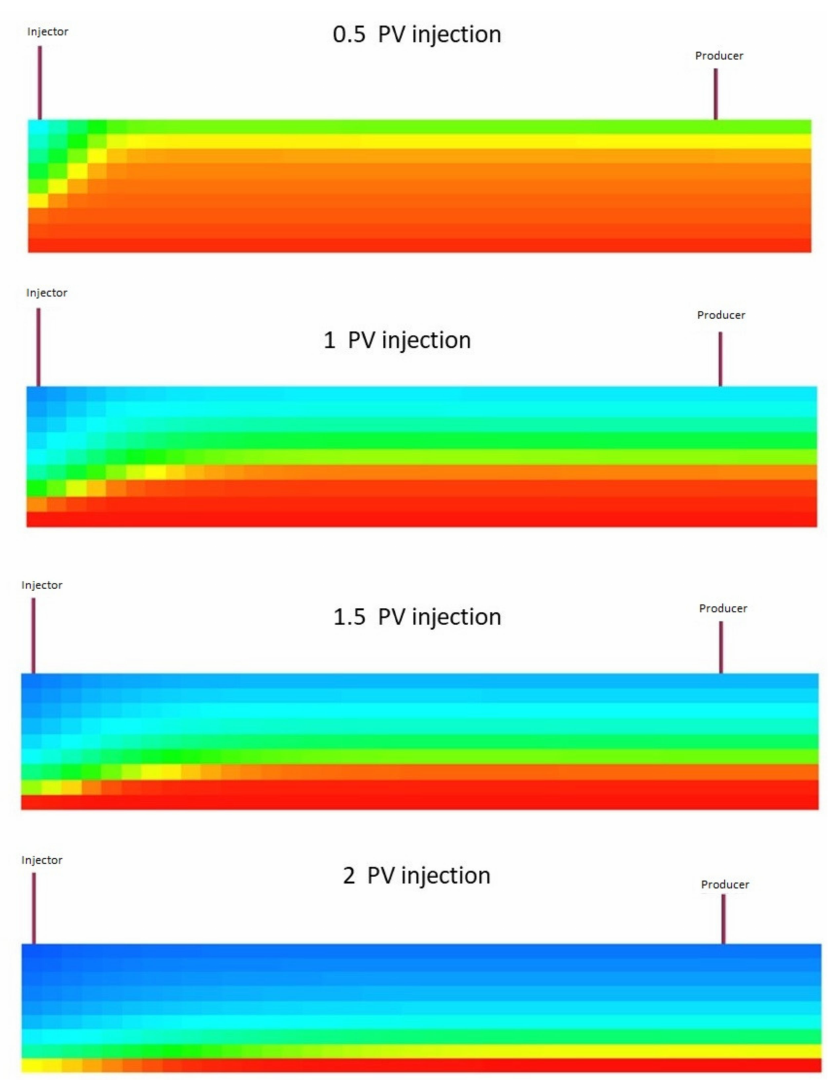
Figure 15. Saturation profile for FWAG for various PV injections (blue for low and red for high oil saturation).